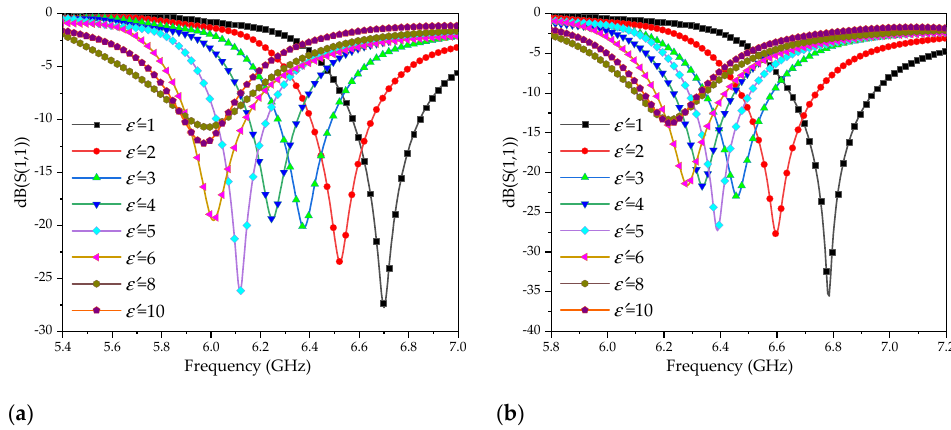
Figure 9. Simulated reflection coefficients under various dielectric constants of the LUT with ordinary containers: ( a ) glass container; ( b ) plastic container.